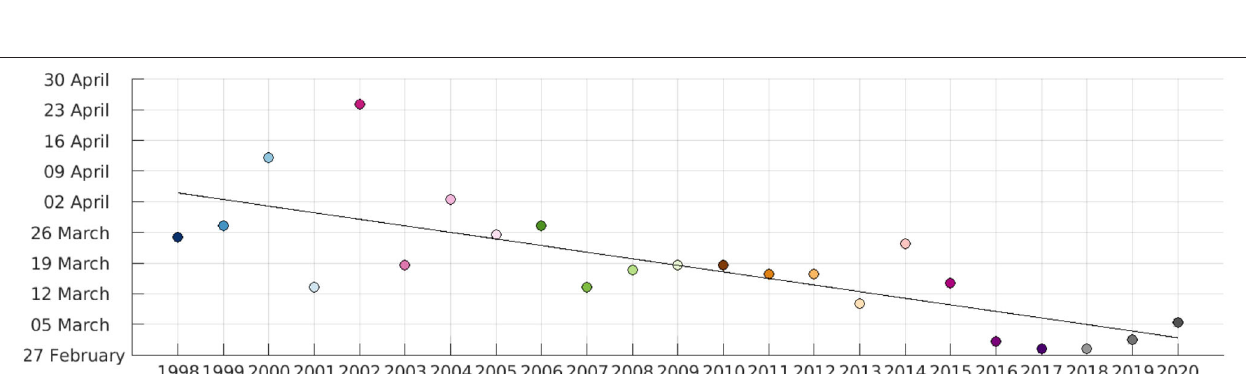
FIGURE 10 | Date on which the CHL concentration reaches the annual median value for the first time each year. The solid black line shows a linear fit to the dates, with r = 0.75 and a p -value of 4.1267e-05.